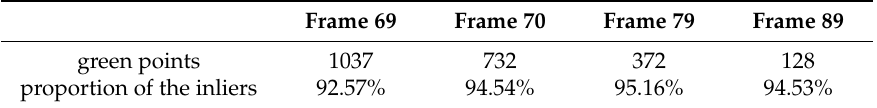
Table 3. Number of the green points and proportion of the inliers.